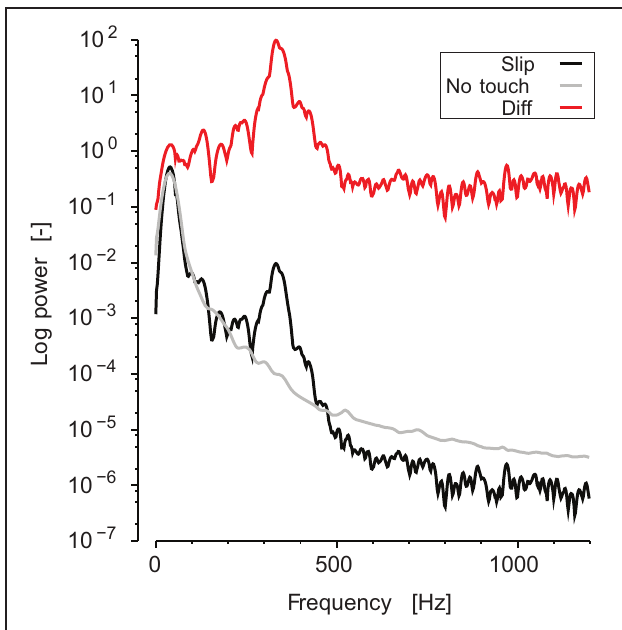
FIGURE 3 | Typical spectrum of the sound recorded. Black line represents the averaged spectrogram during a slipping phase. Gray line represents the averaged spectrogram during a static no-touch phase. Red line is the ratio, which appears as a shift in log coordinates.